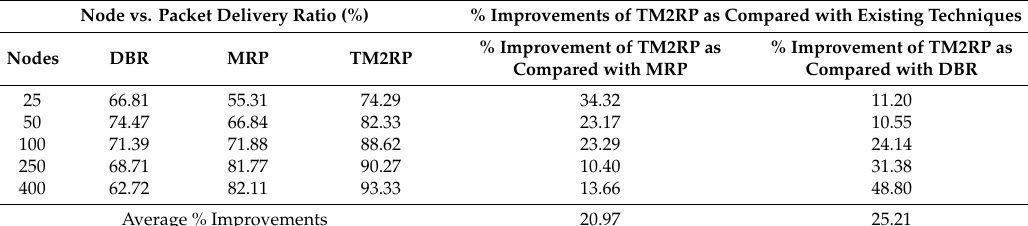
Table 3. The obtained results of TM2RP with regard to packet delivery ratio. Node vs. Packet Delivery Ratio